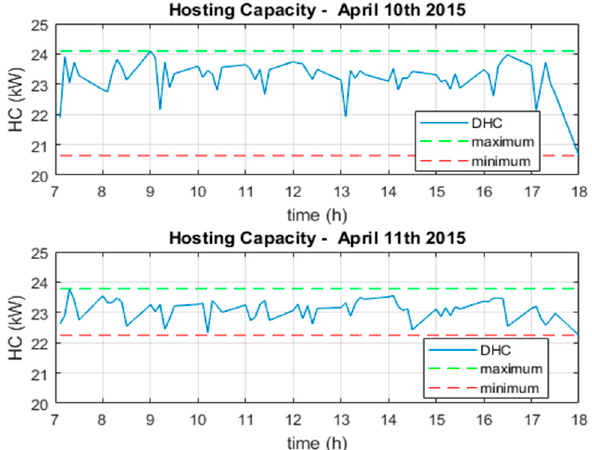
Figure 12. The daily DHC(t) for the in relation to April 12th and 13th, 2015.